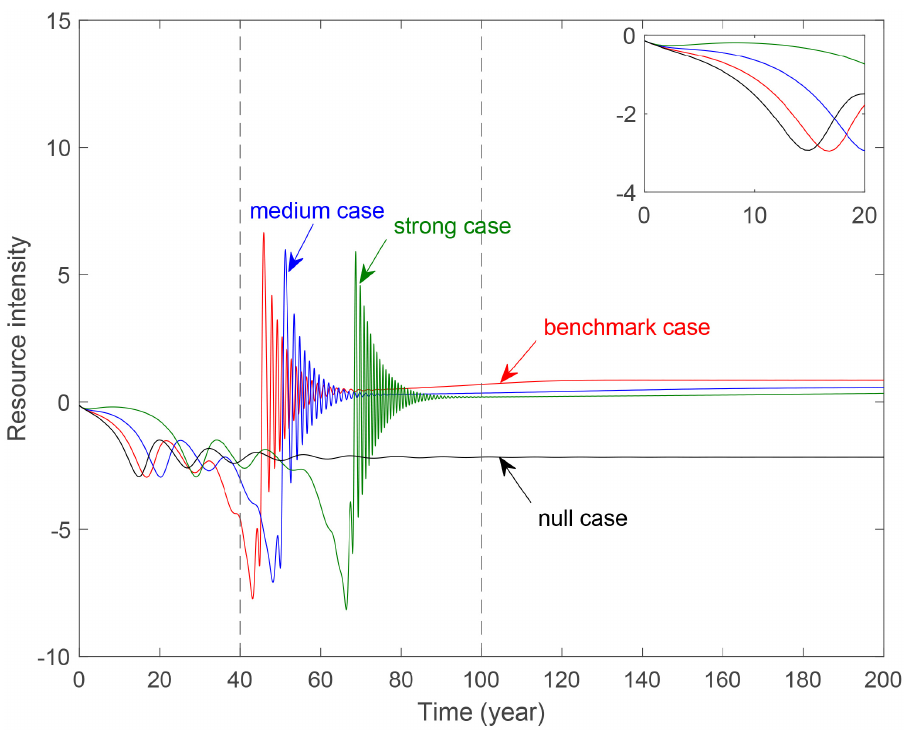
Fig 11. Evolution of resource intensity with different government control parameter b 4 . Benchmark case : b 4 = 0.2488. Medium case : b 4 = 0.4488. Strong case : b 4 = 0.6488.